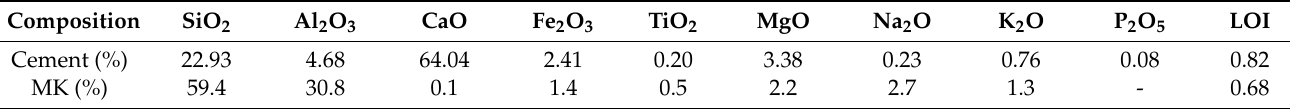
Table 1. Chemical composition of Type I Portland cement and metakaolin